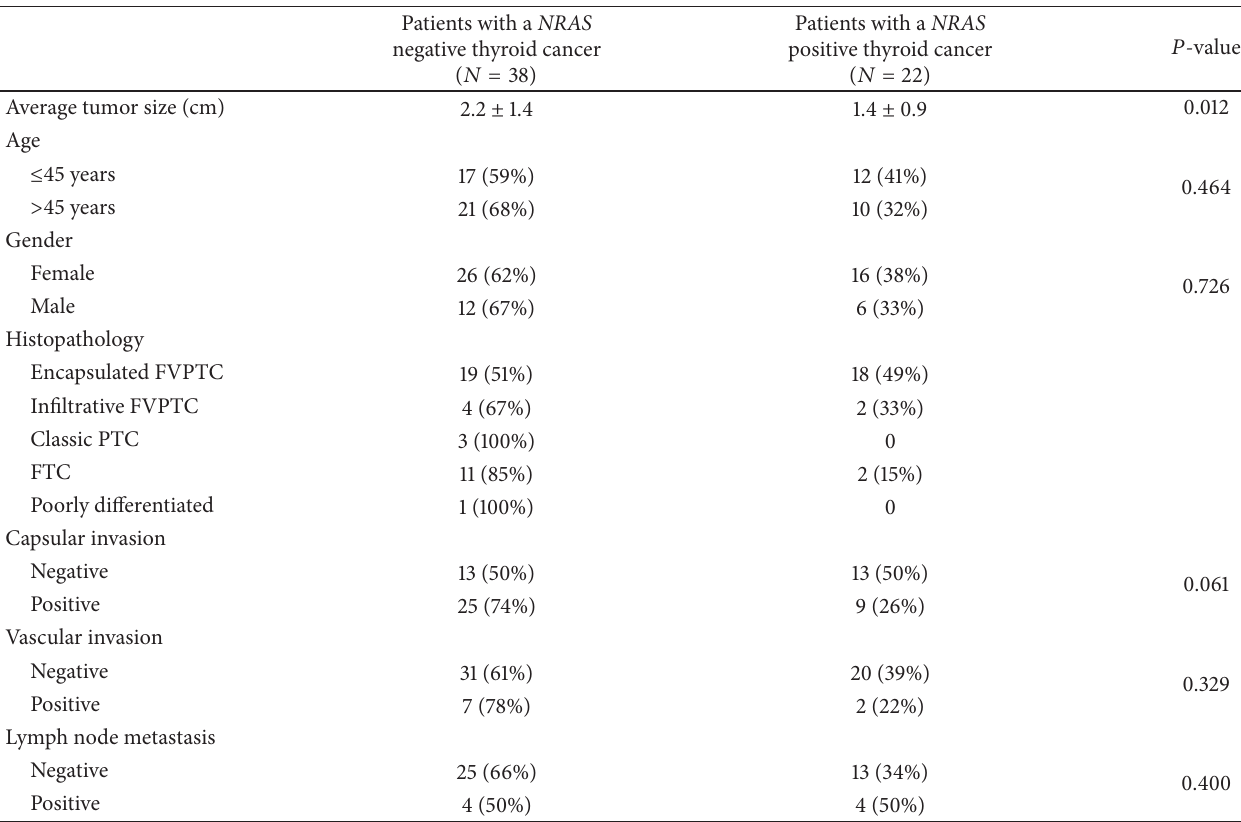
Table 2: Clinicopathologic features and the NRAS mutation status of 60 thyroid cancers with a preoperative diagnosis of follicular